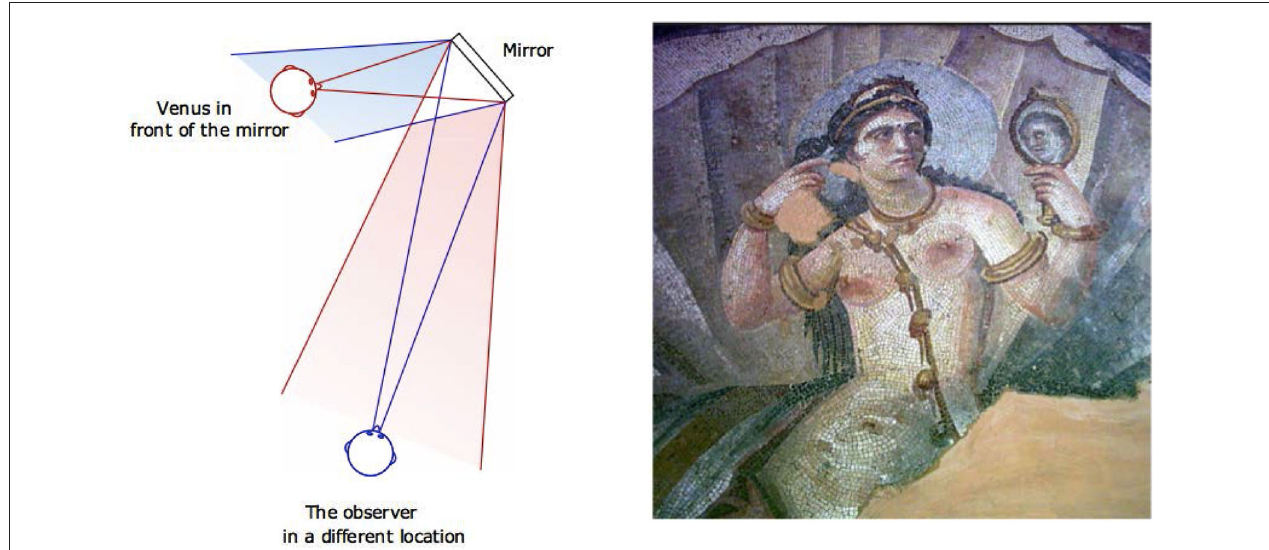
FIGURE 1 | The diagram shows that what Venus sees is different from what the observer sees . For the observer to see Venus’s face, Venus should see the observer’s face. On the right is an early example of the toilette of Venus/Aphrodite. This mosaic (3rd century) found in the environs of Philippopolis is now in the Suweida Museum